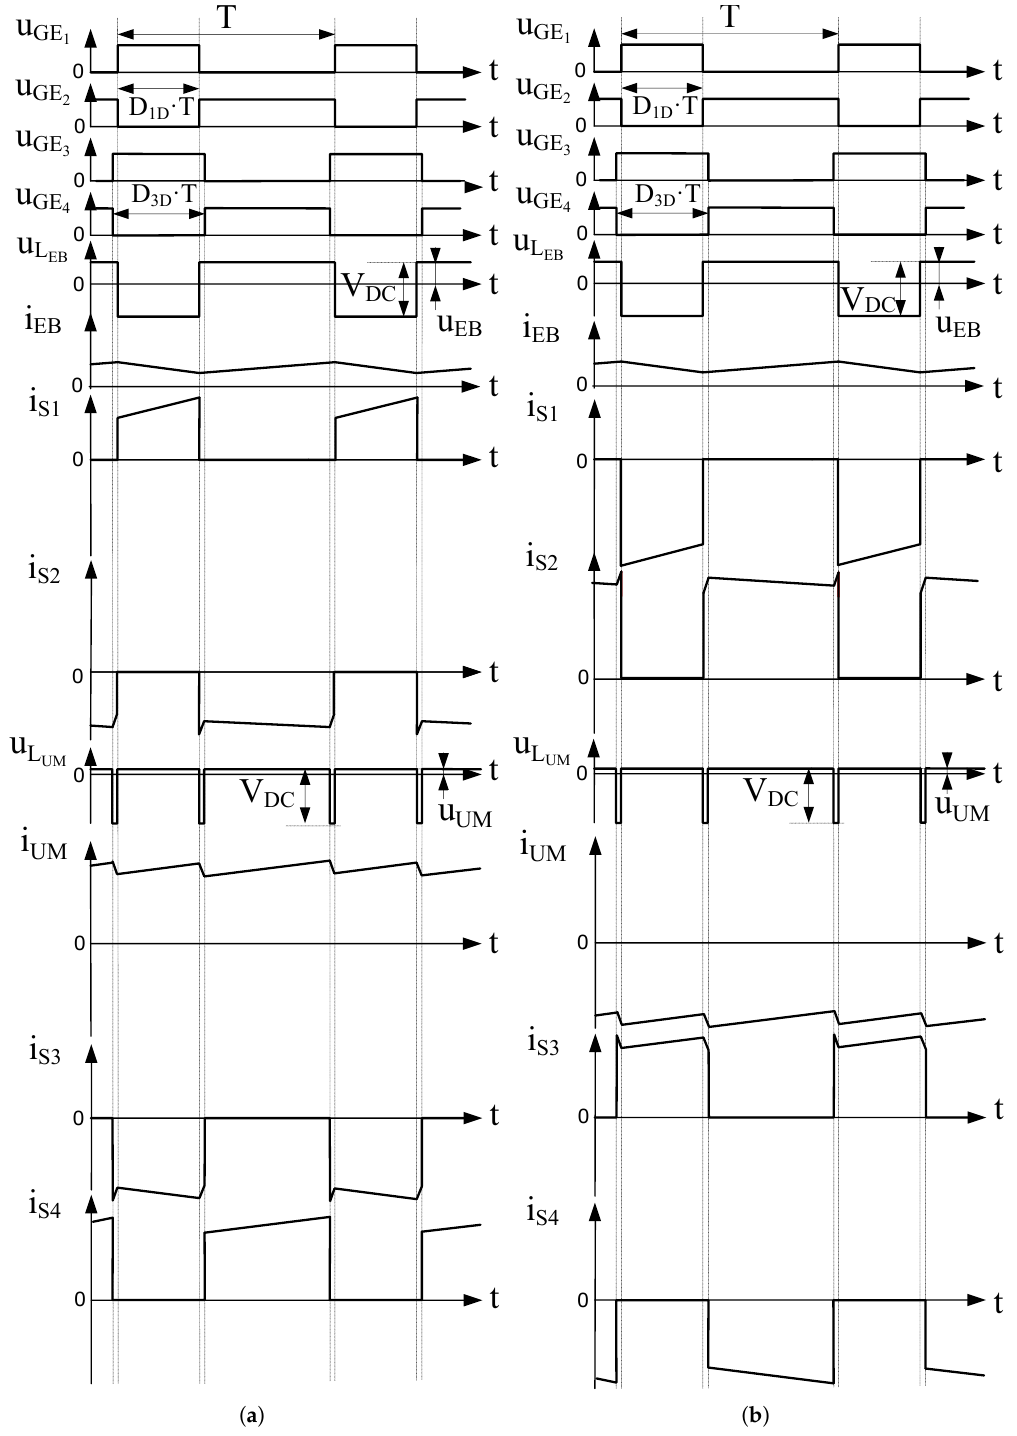
Figure 7. Theoretical waveforms of the SPC scheme: ( a ) EB and UM both are in discharge mode; and ( b ) EB is in discharge mode but UM is in charge